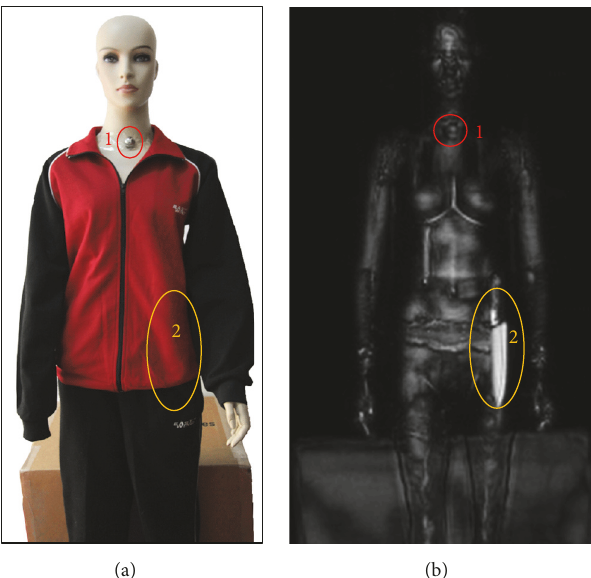
Figure 7: Photograph of the human body model carrying a concealed knife and a metallic sphere (a); orthogonal projection of the 3D microwave image result onto the azimuth-elevation ( 𝑌 - 𝑍 ) plane for display